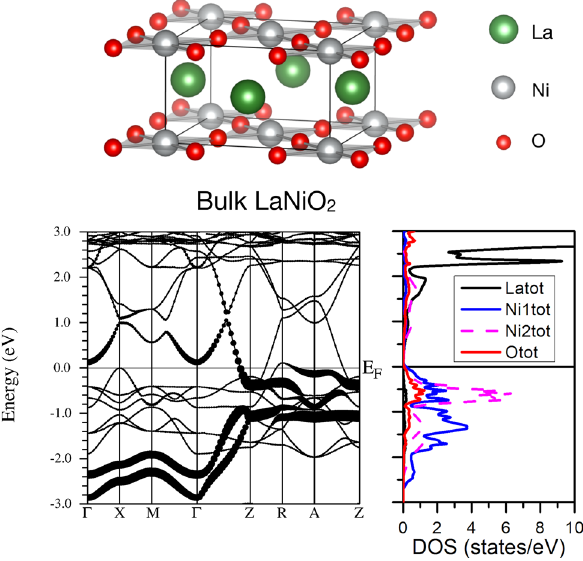
Figure 3. Top panel. Structure of LaNiO 2 . La atoms in green, Ni in grey, O in red. The structure highlights the NiO 4 square planar environment surrounding each Ni cation forming the NiO 2 building blocks of the layered structure in superconducting nickelates. Bottom left panel. Band structure of bulk LaNiO 2 within GGA in its AF ground state with the fat bands representing the Ni- d z 2 states of both Ni atoms in the structure (a Hund splitting lead to metallic behavior in the bulk. Bottom right panel. Corresponding La, O, and Ni atom-resolved density of states (both Ni atoms have opposite